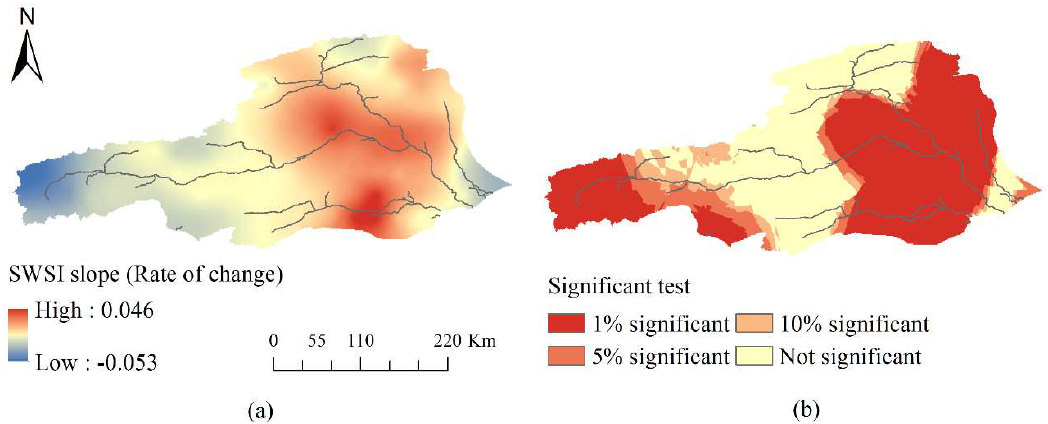
Figure 7. ( a ) The slope (rate of change) of annual surface water supply index (SWSI) during the period of 1980–2010 and ( b ) the significant test of SWSI slope.